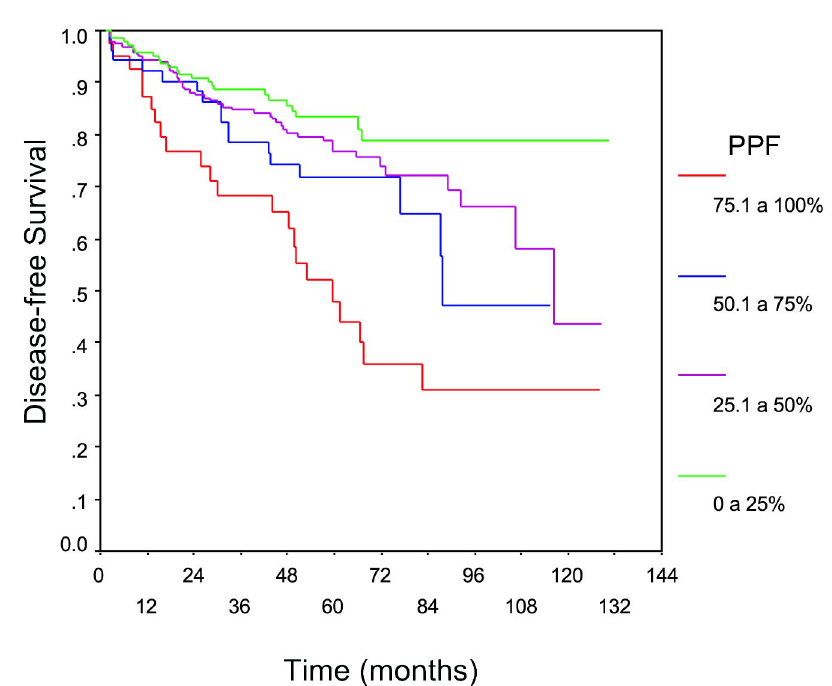
Figure 2 – Probability curve of disease-free survival according to the percentage of positive fragments (PPF) at pre-operative